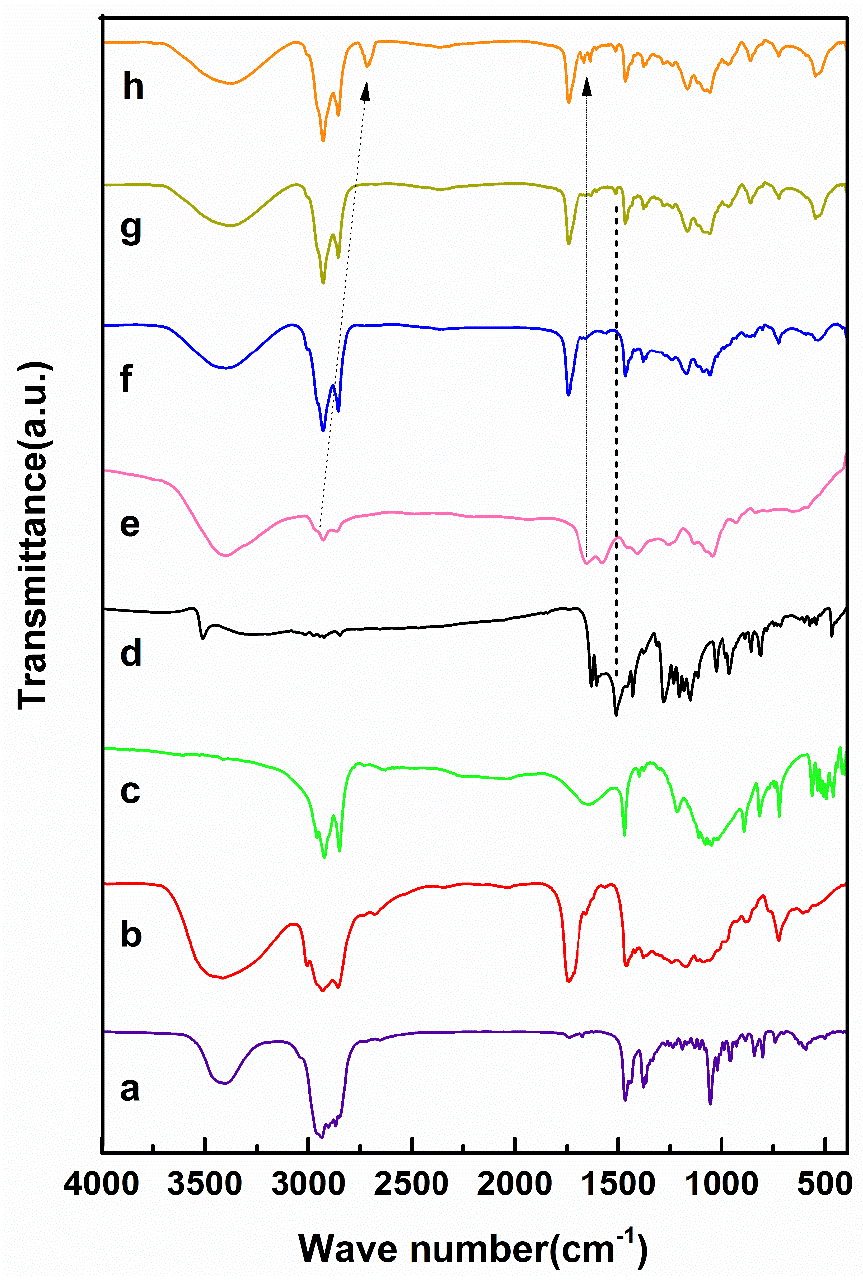
Figure 5. Fourier-transform infrared (FTIR) Spectra of ( a ) cholesterol, ( b ) Span80, ( c ) DCP, ( d ) cur- cumin, ( e ) calcium alginate ( f ) niosome, ( g ) curcumin-loaded niosome, and ( h ) curcumin-loaded niosome-incorporated alginate.